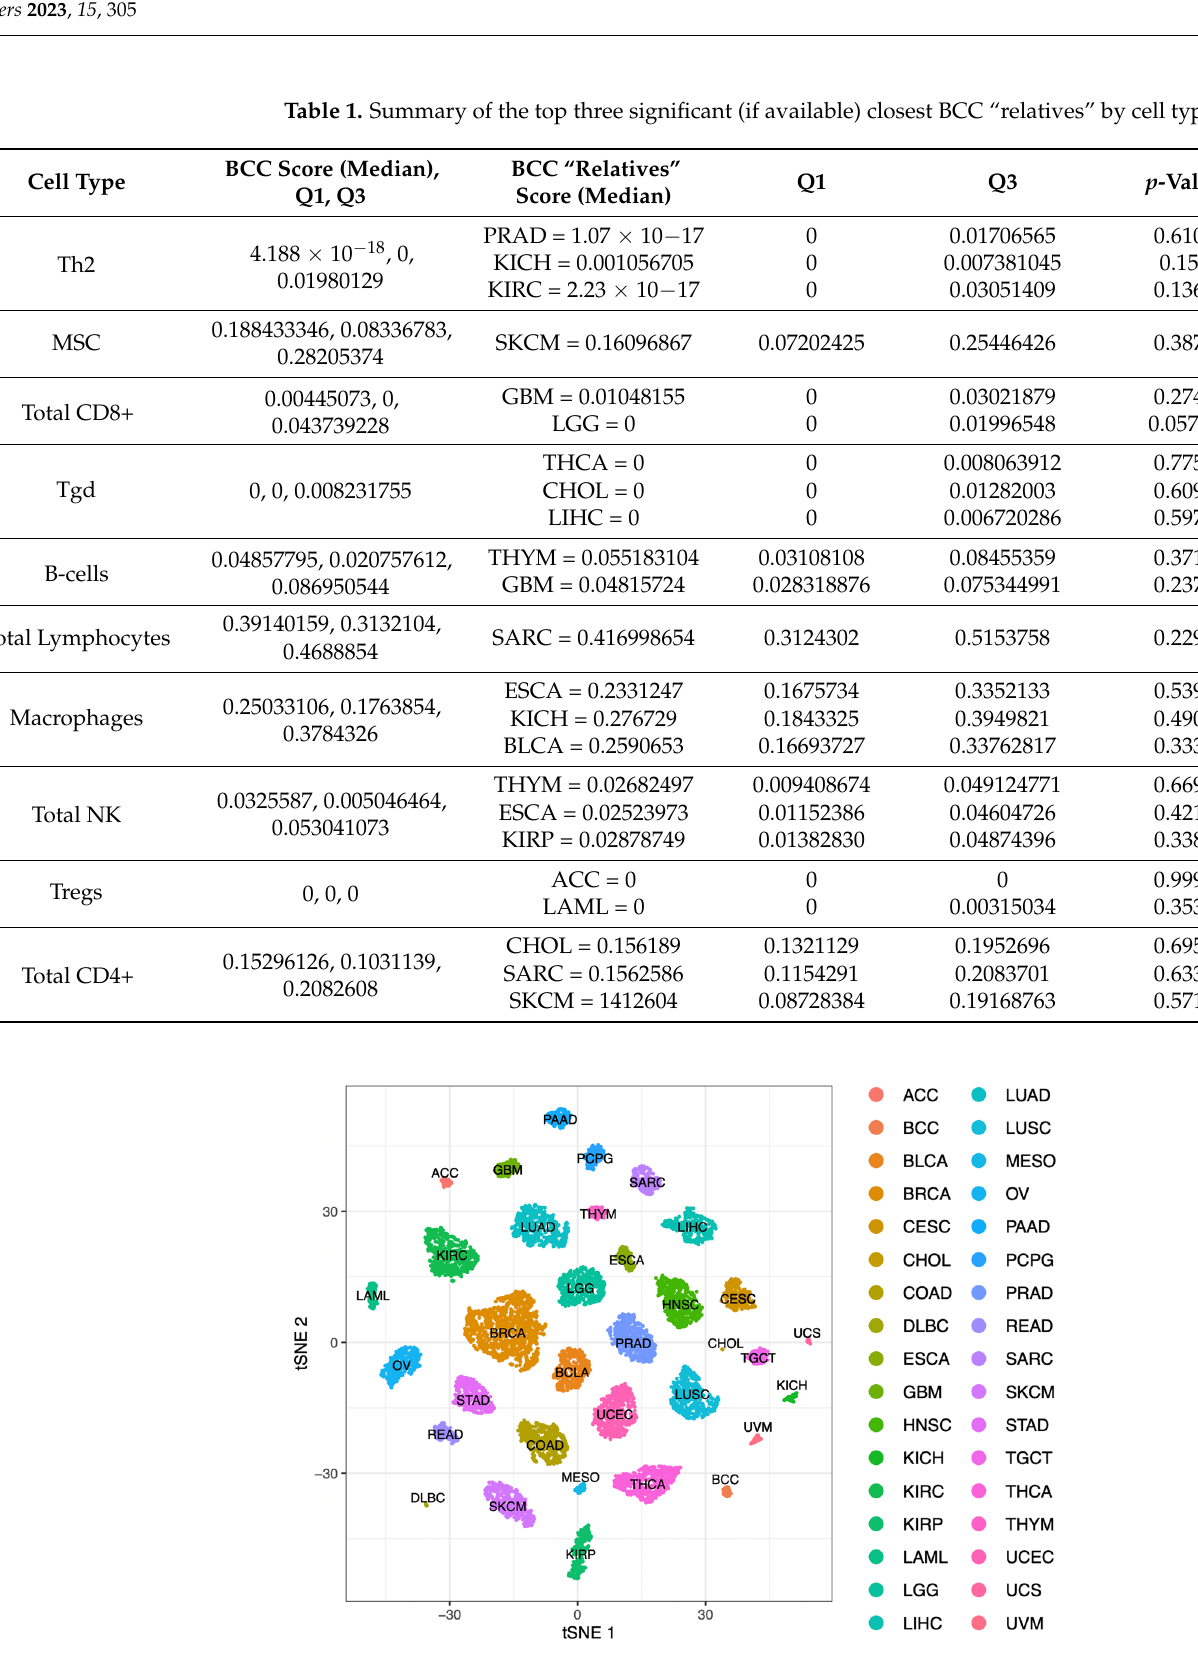
Figure 3. t -distributed stochastic neighbour embedding plot of the tumour microenvironment scores (from CIBERSORTx and xCell) of 33 TGCA cancers with BCC, coloured by cancer type.